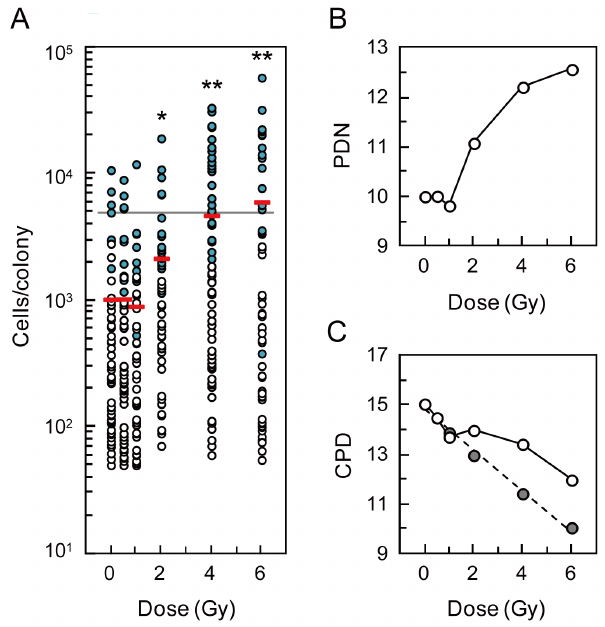
Figure 6. Changes in population doublings of HLEC1. (A) Cell numbers in individual clonogenic colonies. Cell numbers in 218 countable clonogenic colonies (open circles) were directly counted under the stereomicroscope, and those in 99 uncountable colonies (blue-filled circles) were estimated as described in Figures S4, S5 and S6. Red bars indicate the means at each dose point. A horizontal line indicates the mean + 2SD value (4,944 cells) in sham-irradiated controls. *0.01 # p , 0.05 and ** p , 0.01 compared with sham-irradiated controls. (B) PDN of clonogenic cells experienced during colony formation. To calculate PDN, cell numbers in individual clonogenic colonies (shown in Figure 6A) were summed, divided by the number of clonogenic colonies (i.e., the number of clonogenic cells plated), and then transformed to the logarithm to base 2. (C) CPD of all cells in the whole population. For calculation of the data, cell numbers in clonogenic colonies (shown in Figure 6A) were first summed. Second, the number of all cells situated outside clonogenic colonies (i.e., cells in abortive colonies or other nonclonogenic cells) was directly counted under the stereomicroscope and summed. Third, the sum of these cell numbers was divided by the number of plated cells, and transformed to the base-2 logarithm. Finally, 11.0 (CPD when plated) was added to these numbers, and shown as open circles with a solid line. Gray-filled circles with a dotted line represent CPD of all cells calculated assuming that irradiation does not alter the proliferation of clonogenic cells (i.e., PDN of irradiated clonogenic cells is the same as PDN of sham- irradiated controls regardless of dose).